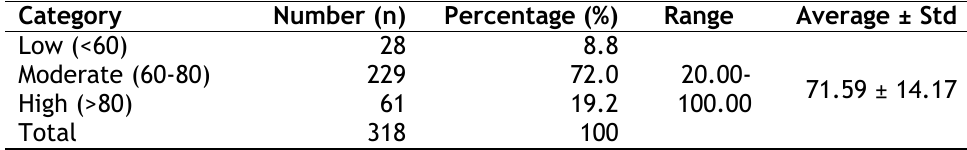
Table 2. Category and descriptive analysis of consumer satisfaction